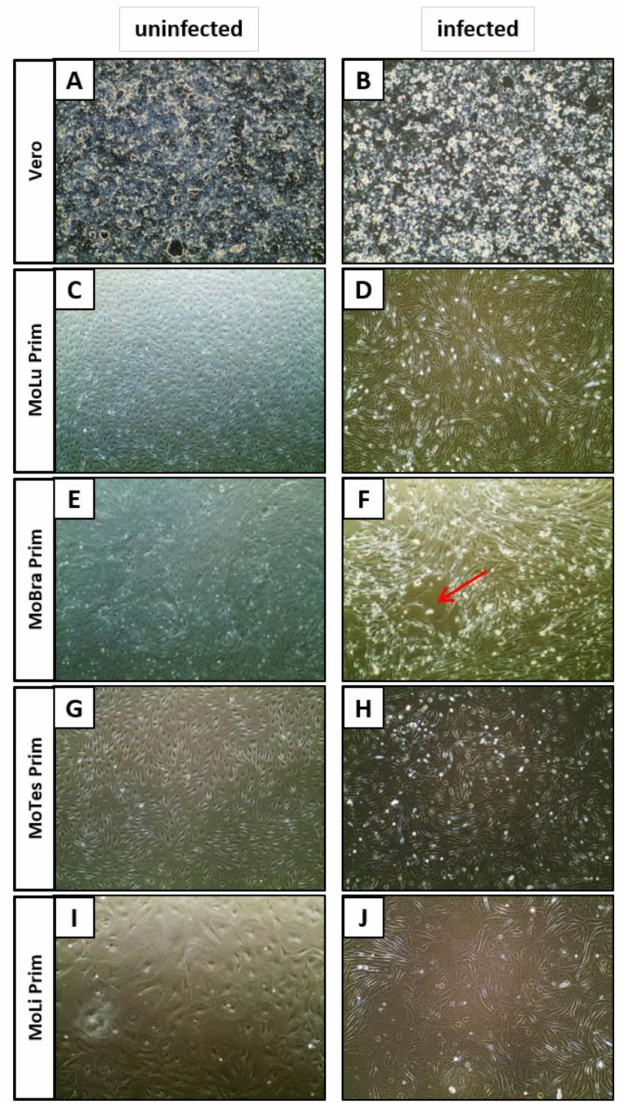
Figure 2. Cytopathogenicity in EBOV-infected cells. Phase contrast microscopy of uninfected cells ( A , C , E , G , I ) and EBOV-infected cells 16 dpi ( B , D , F , H , J ). CPE with enlarged cells ( B ), enhanced cell division ( D , H , J ), or plaques (( F ), red arrow). Magnification: 10 ×